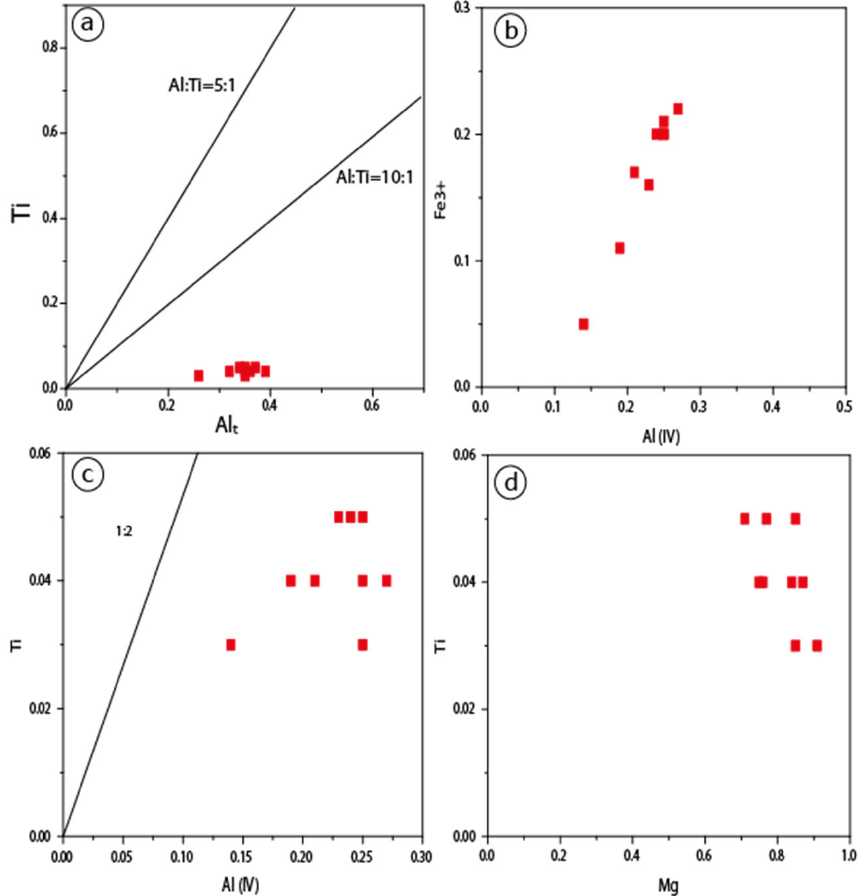
Figure 8. Pyroxene xenolith compositions ( a ) Ti vs. Al diagram, in which most samples are located in the Al/Ti zone > 10, ( b ) Fe 3+ vs. Al IV diagram where a strong linear correlation between these two cations is observed. ( c ) Ti vs. Al IV diagram, showing a broad positive correlation between the two, ( d ) Ti vs. Mg diagram showing a negative correlation, revealing the increase in Ti at the expense of